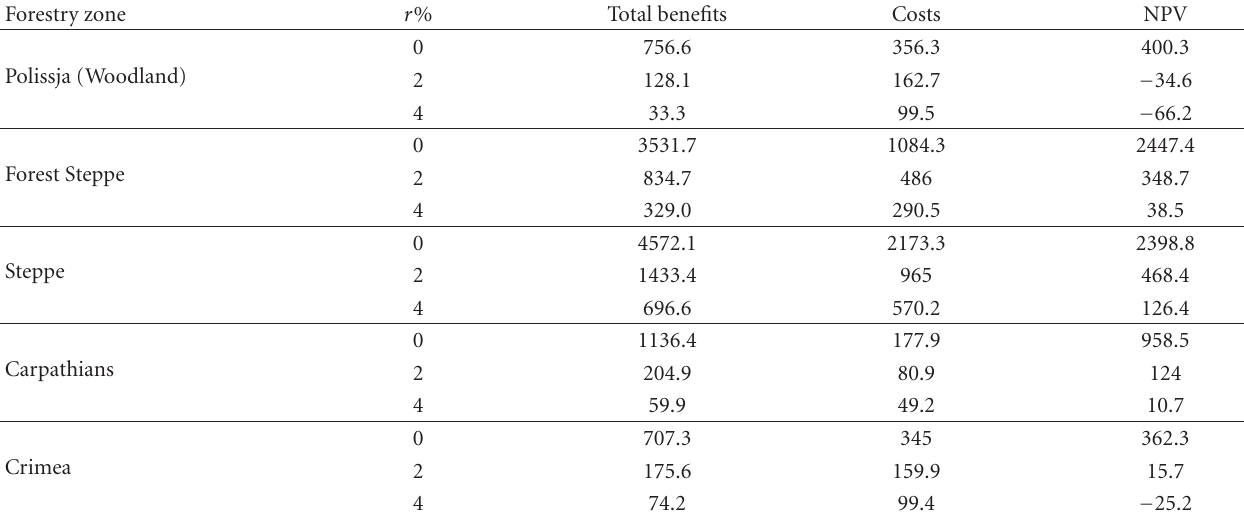
Table 8: Economic evaluation of a ff orestation across zones, PV